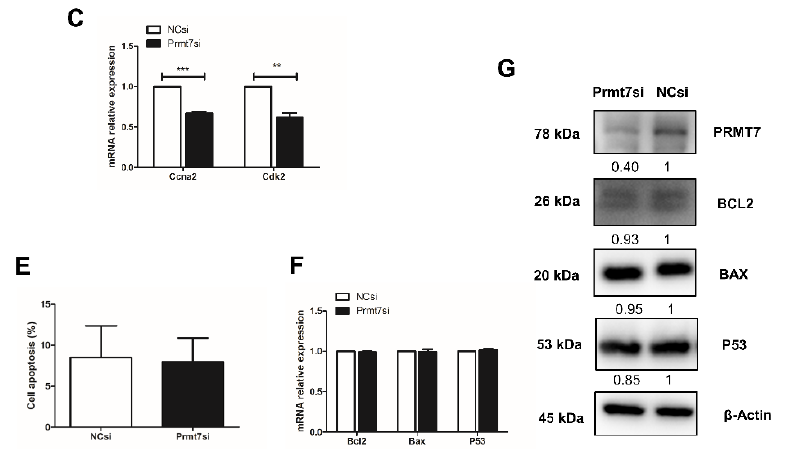
Figure 3. Effects of Prmt7 knockdown on spermatogonial proliferation and apoptosis. ( A ) Cell proliferation was determined by CCK-8 assay after NC and Prmt7 siRNA transfection into spermatogonia for 48 h. ( B ) Cell cycle was analyzed by flow cytometry after NC and Prmt7 siRNA transfection into spermatogonia for 48 h. ( C ) Relative mRNA expression of Ccna2 and Cdk2 examined by RT-qPCR in spermatogonia transfected with NC and Prmt7 siRNA for 48 h. ( D ) The protein level of PRMT7, CCNA2, and CDK2 detected by Western blotting in spermatogonia transfected with NC and Prmt7 siRNA for 48 h. ( E ) Cell apoptosis was analyzed by flow cytometry after NC and Prmt7 siRNA transfection into spermatogonia for 48 h. ( F ) Relative mRNA expression of Bcl2 , Bax , and P53 was examined by RT-qPCR in spermatogonia transfected with NC and Prmt7 siRNA for 48 h. ( G ) The protein levels of PRMT7, BCL2, BAX, and P53 were detected by Western blotting in spermatogonia transfected with NC and Prmt7 siRNA for 48 h. Data from three independent experiments are expressed as mean ± SEM. * indicates statistical significance. * p < 0.05, ** p < 0.01, and *** p <